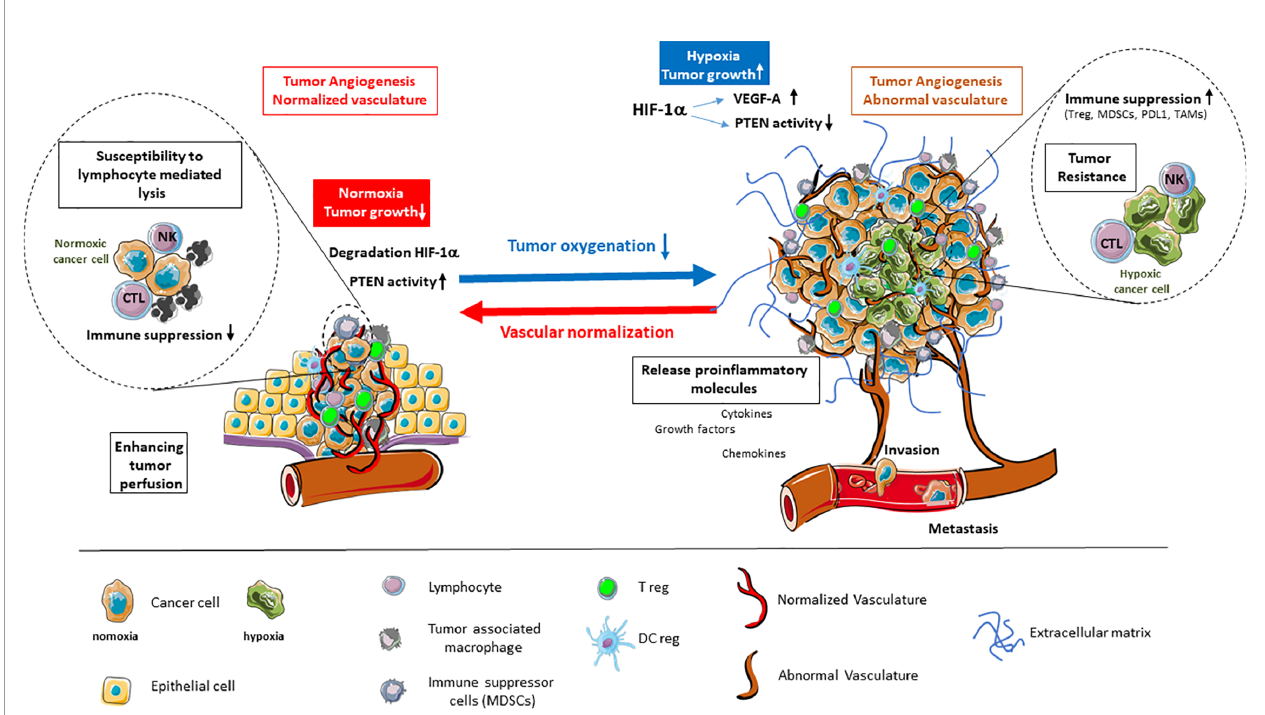
FIGURE 1 | Alleviation of tumor hypoxia by vascular normalization reprograms the tumor microenvironment. Hypoxia in the tumor microenvironment promotes tumor angiogenesis and abnormal vascularization through the activation of HIF-1 a and downstream effector genes, such as VEGF-A, while inhibiting the tumor suppressor PTEN. This is coupled by enhanced immune suppression, the release of proin fl ammatory molecules, as well as the promotion of invasion and metastasis. The alleviation of tumor hypoxia through vascular normalization enhances tumor perfusion, leading to the degradation of HIF-1 a and restoration of PTEN activity. The reestablishment of normal oxygenation additionally counteracts tumor growth through the revitalization of the immune